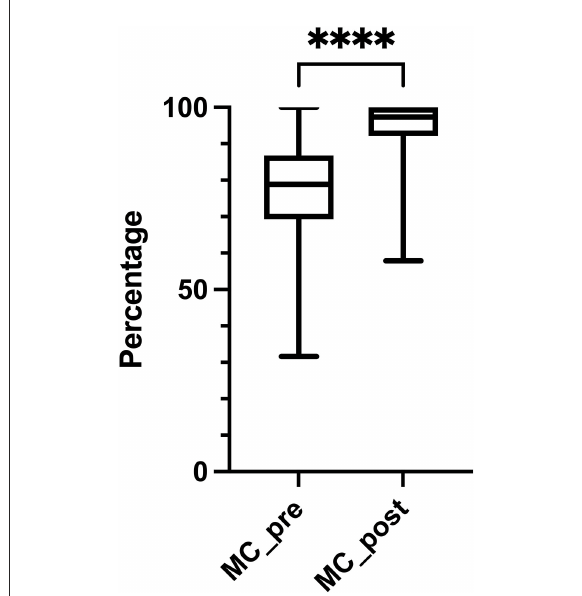
FIGURE1 Knowledge gain. The median percentage of correctly answered multiple-choice test questions significantly increased